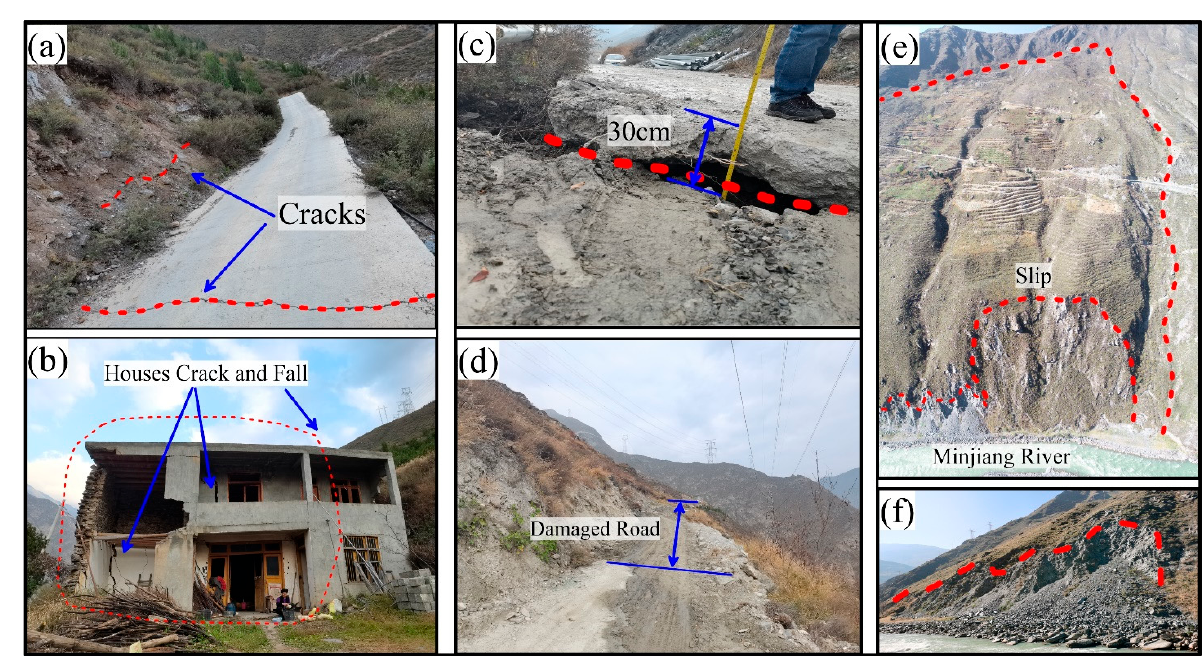
Figure 4. ( a , b ) Field verification pictures of d1 slope in Figure 3d; ( c , d ) Field verification pictures of d2 slope in Figure 3d; ( e , f ) Field verification pictures of d3 slope in Figure 3d.